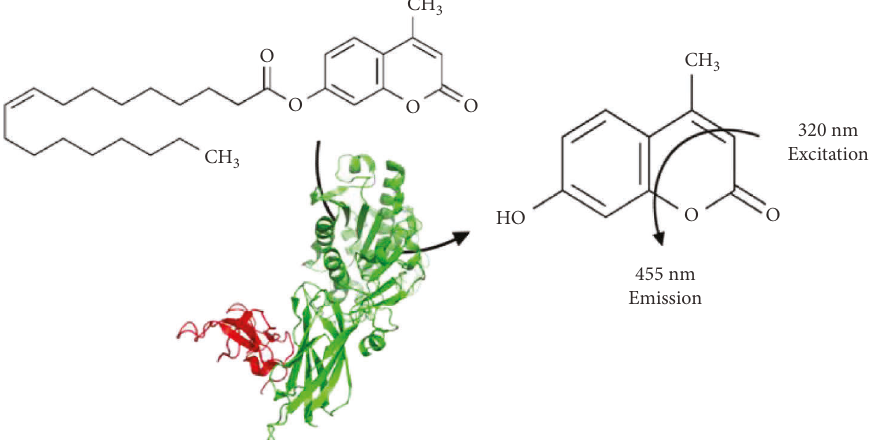
Figure 1: The hydrolysis of 4-methylumbelliferyl oleate (4-MUO) by lipase. When the ester bond of 4-MUO is hydrolyzed, oleate and fluorophoric 4-methylumbelliferone (4-MU) are simultaneously liberated. Fluorescence of 4-MU can be easily detected at an excitation wavelength of 320 nm and an emission wavelength of 455nm using